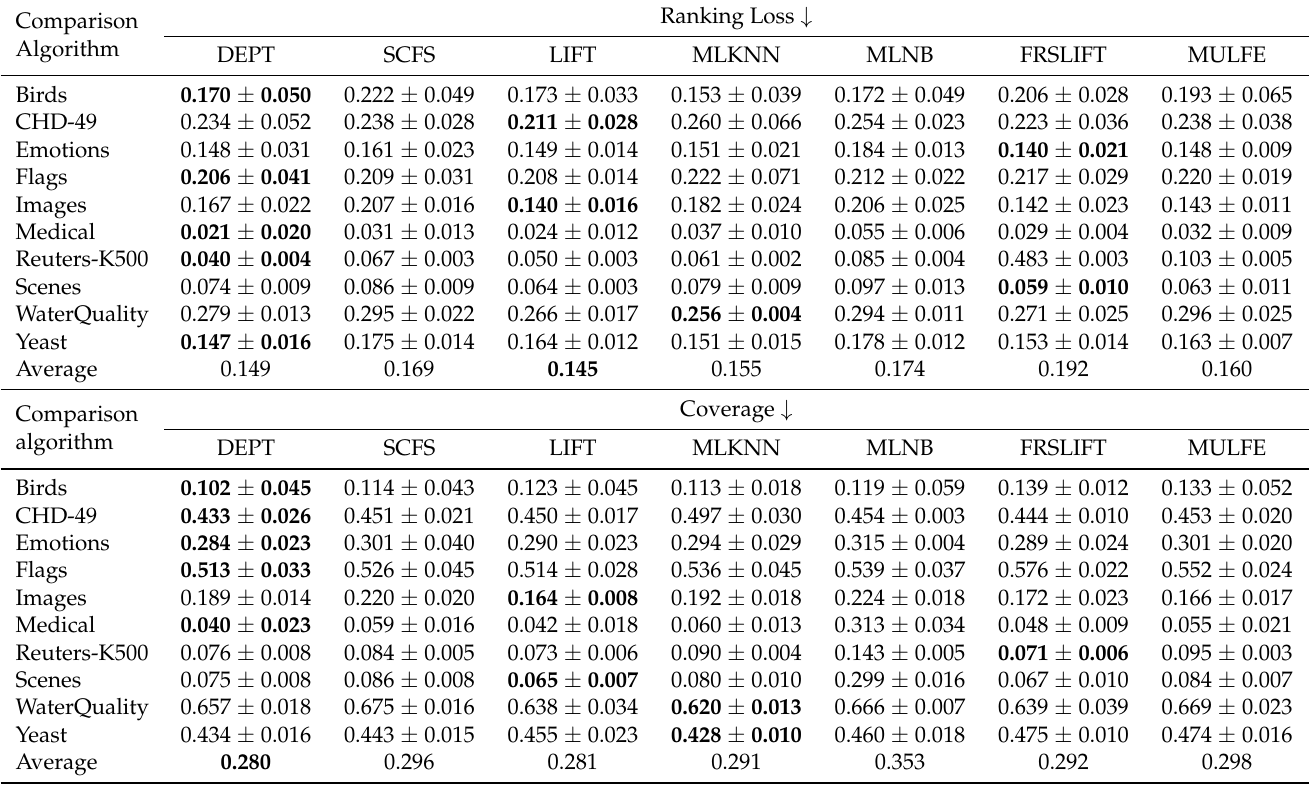
Table 4. Experimental results of each comparison algorithm (mean ±